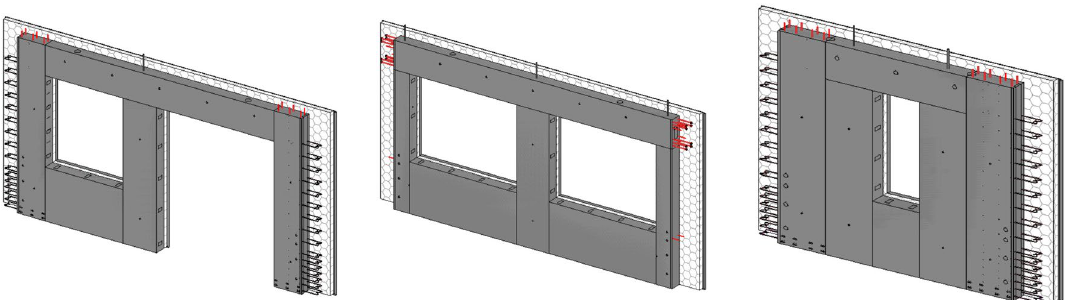
Figure 12. A complete parametric PC component is